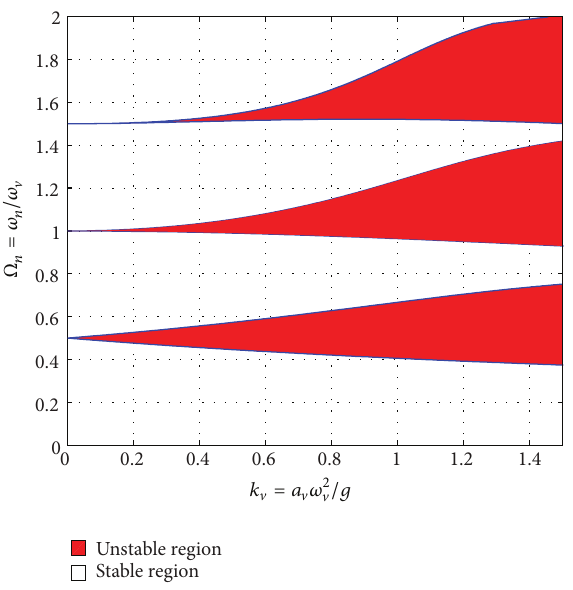
Figure 2: Stability chart for dynamic stability of free-surface under vertical